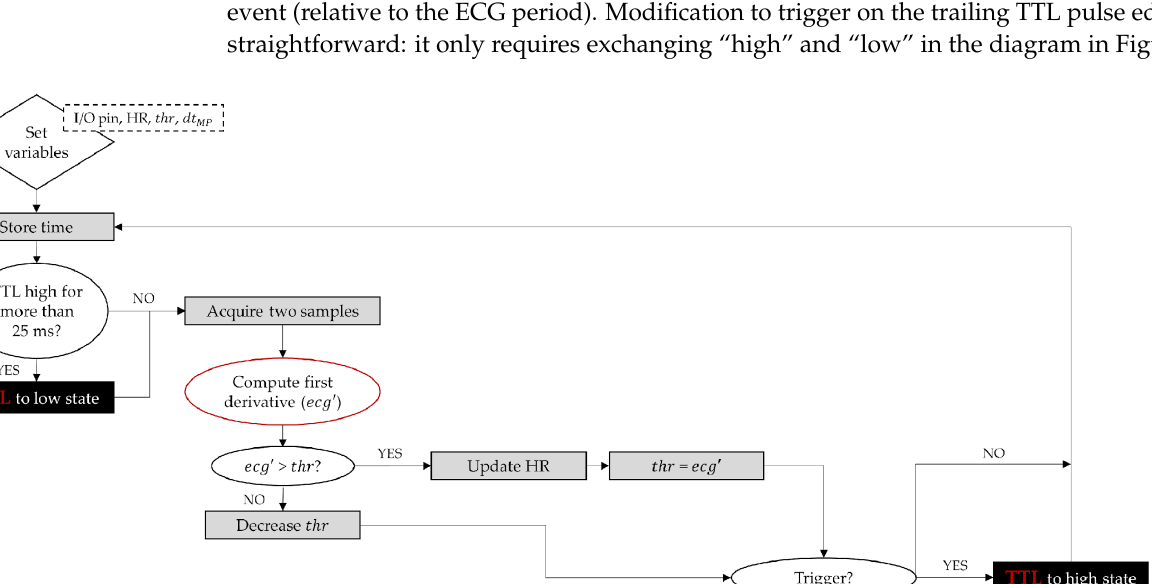
Figure 3. ECG to TTL algorithm diagram.